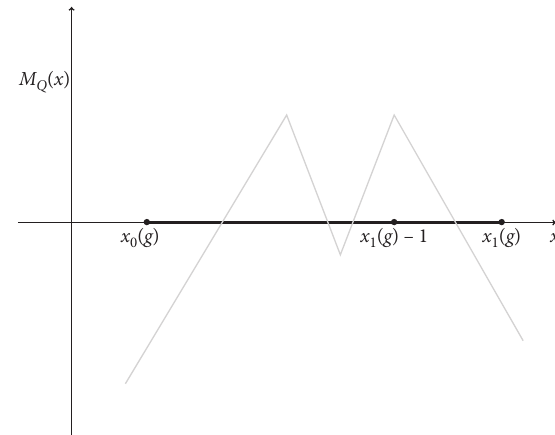
Figure 5: Graph of M ( x ) (gray colored) and the disposal of Q endpoints of a generation (interval generation in black color).